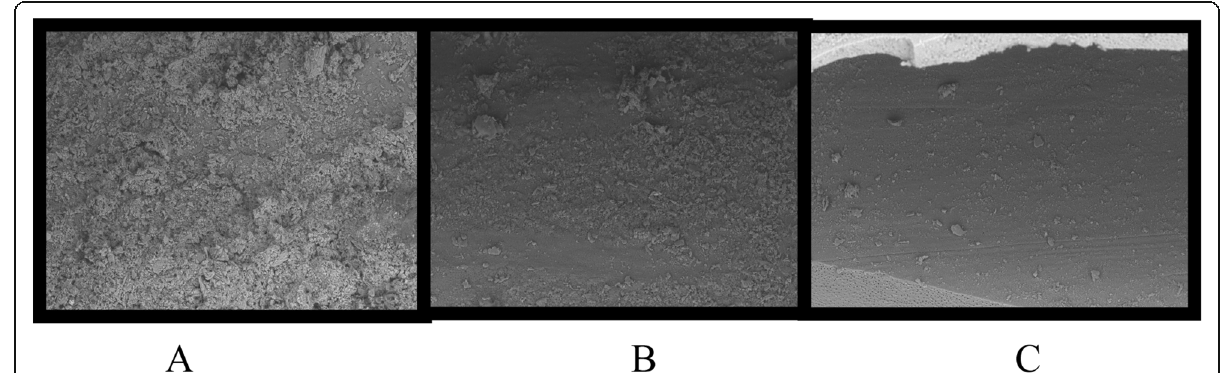
Fig. 10 SEM images of group 5. a Coronal. b Middle. c